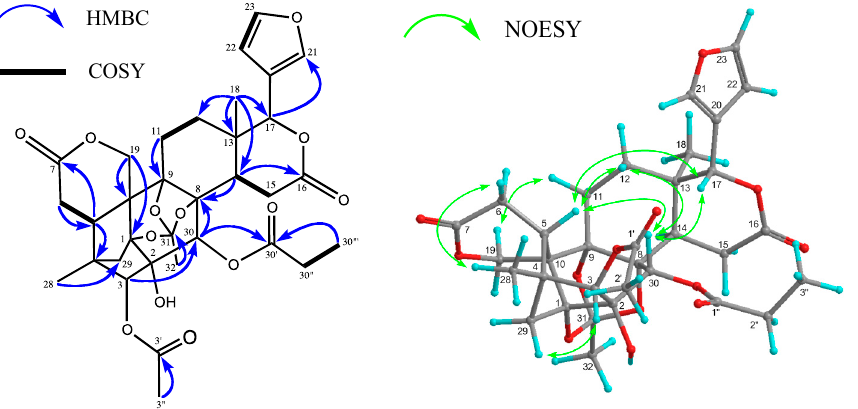
Figure 4. Key HMBC, 1 H— 1 H COSY, and NOESY correlations of carapanolide L ( 3 ).